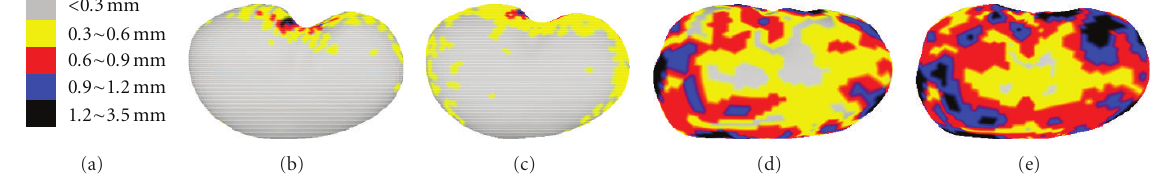
Figure 19: Representation error in intermodel Ex1: (a) color-coded scales, (b) example of color-coded point error in training set, (c) 90% color-coded point error in training set, (d) example of color-coded point error in testing set, and (e) 90% color-coded point error of testing set.